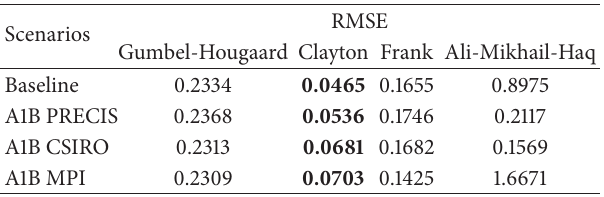
Table 2: RMSE of fitting four copula functions to joint distributions for drought severity and duration under baseline and three A1B